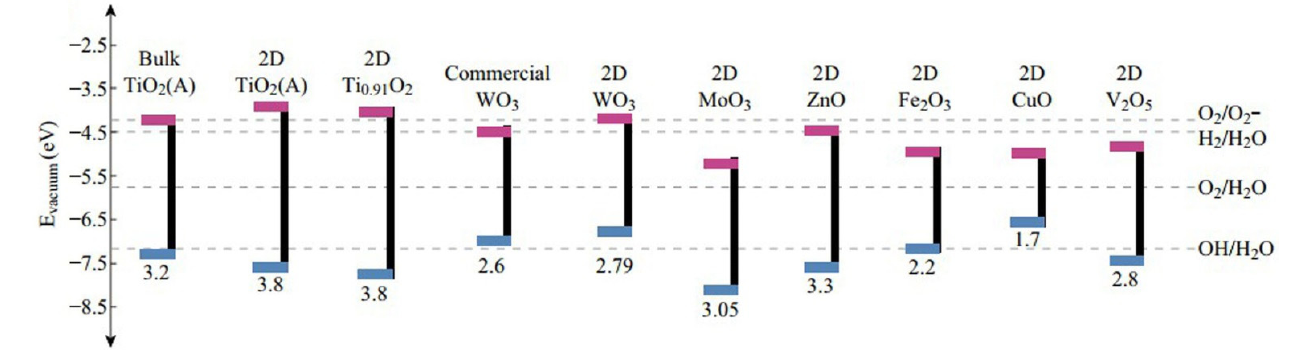
Figure 3. Band energy gaps of selected semiconductors. (Reproduced with permission from [43], copyright 2017, Springer Nature)